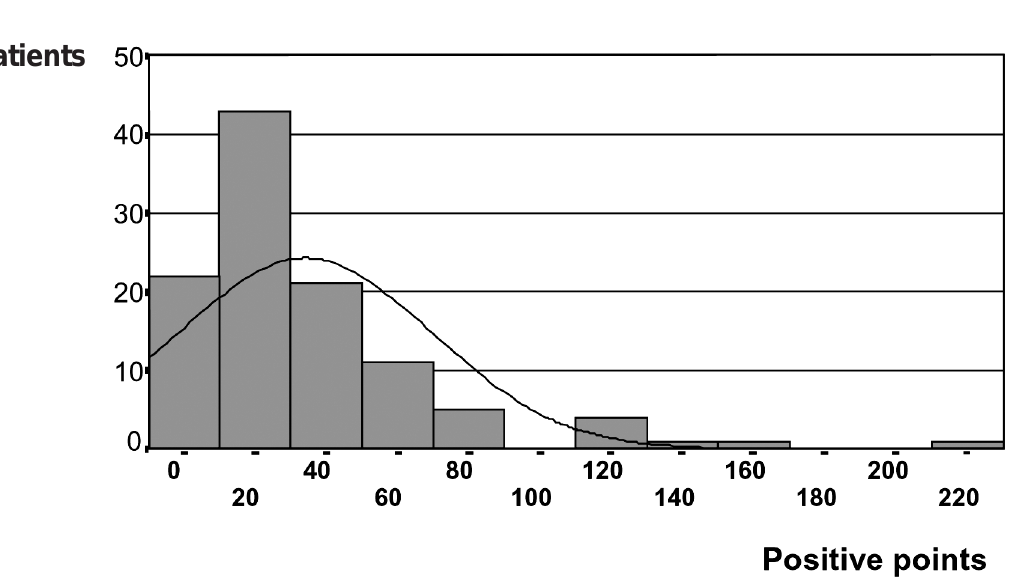
Figure 4 – Distribution of positive points in 109 patients submitted to radical prostatectomy.